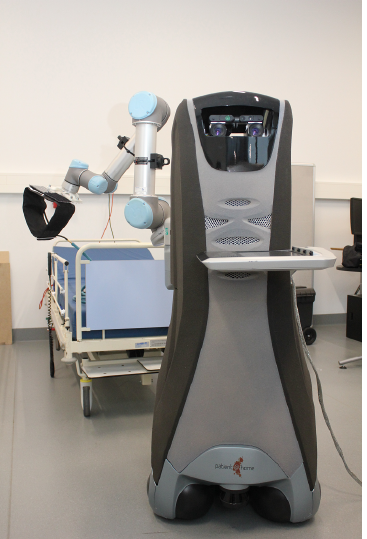
Figure 1: The Care-O-bot with a standard blood pressure measure- ment device attached to its